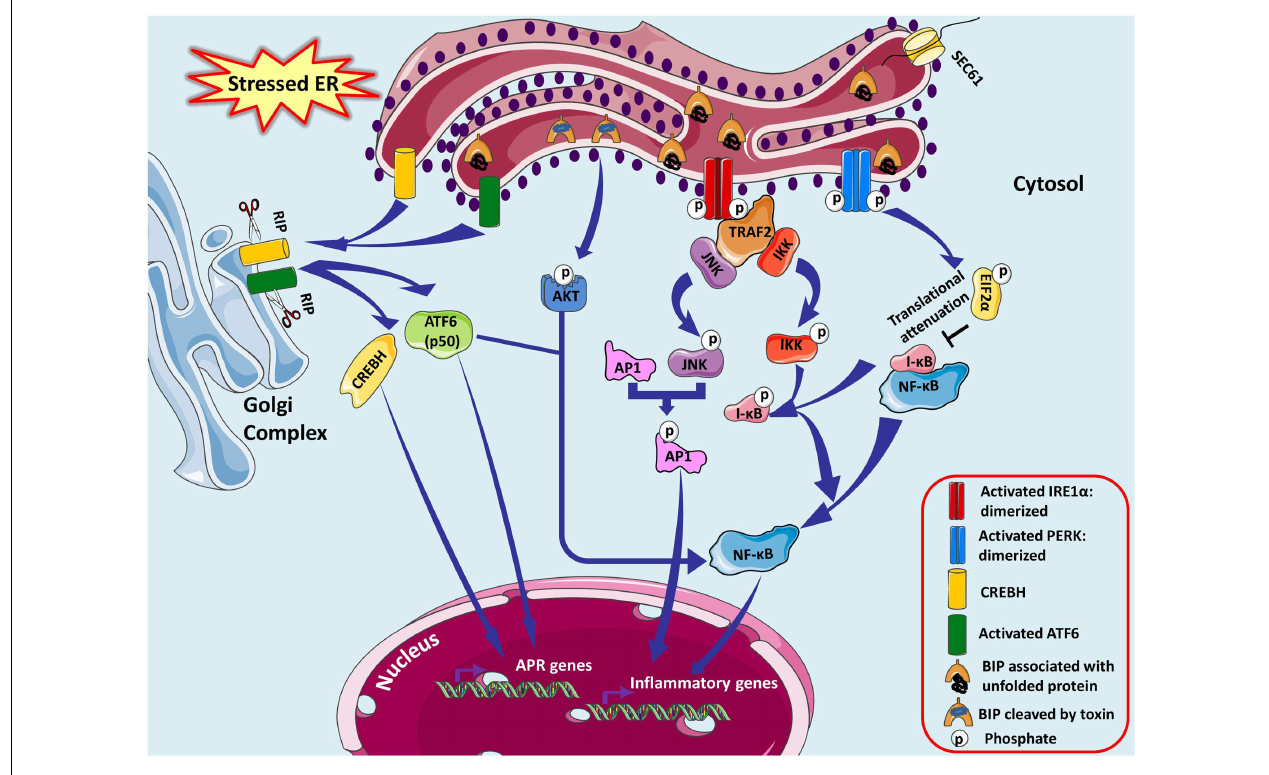
FIGURE 3 | Endoplasmic reticulum stress-associated NF κ B activation is shown . ER stress-induced activation of IRE1 α kinase activity recruits adaptor protein tumor-necrosis factor- α (TNF- α ) receptor-associated factor 2 (TRAF2), which further recruits c-Jun N-terminal kinase (JNK) activating several transcription factors and many apoptosis signaling proteins. JNK induces the expression of inflammatory genes by phosphorylating the transcription factor activator protein 1 (AP-1), which is a dimer of monomers from various protein families forming different combinations of AP-1.They induce inflammation via promoting transcription of genes for